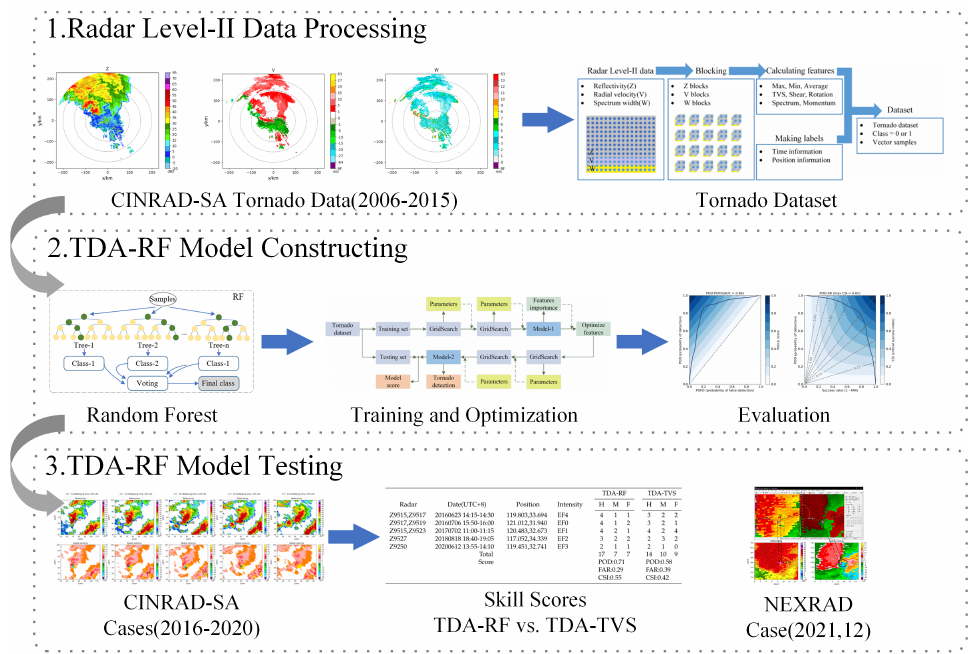
Figure 2. The workflow of this paper. The part 1 corresponds to Section 2, part 2 represents Sections 3 and 4, and part 3 indicates Section